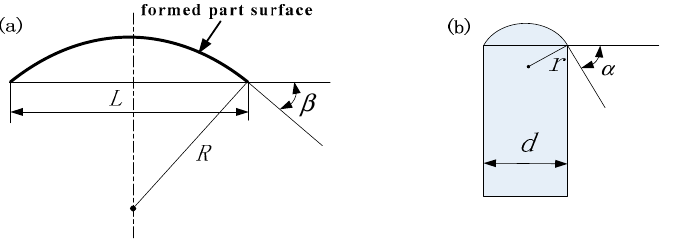
Figure 3. Schematic diagram of formed surface and basic unit’s ball head: ( a ) formed part surface; ( b ) basic